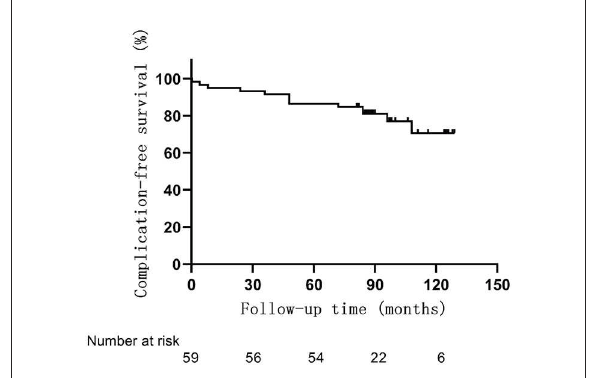
FIGURE3 Overall rate of complications in 59 children with RB optic nerve invasion.